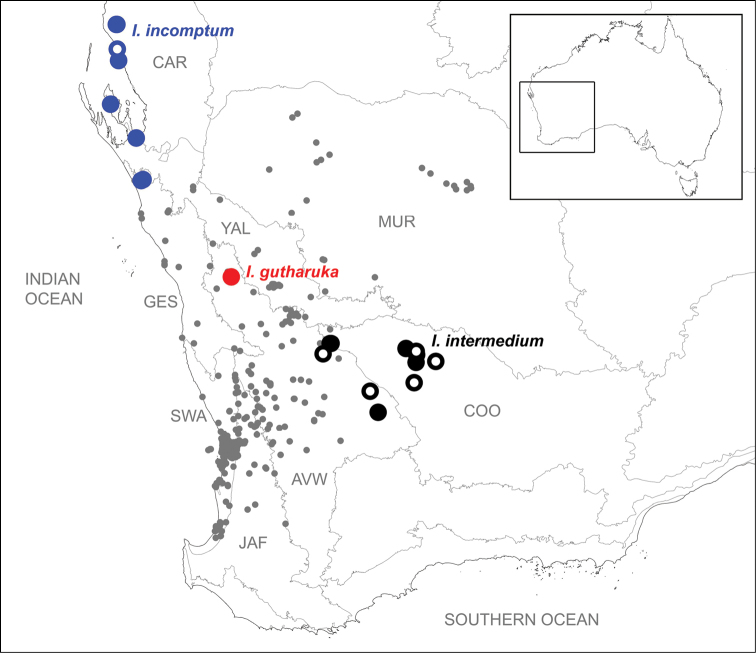
Map showing collection records of Idiosoma species in the intermedium-clade from south-western Australia; base map shows collection records for all other species in the nigrum-group as smaller grey dots. Specimens sequenced for the molecular analyses are denoted by open circles, and relevant IBRA 7.0 bioregions are as follows: AVW, Avon Wheatbelt; CAR, Carnarvon; COO, Coolgardie; GES, Geraldton Sandplains; JAF, Jarrah Forest; MUR, Murchison; SWA, Swan Coastal Plain; YAL, Yalgoo.